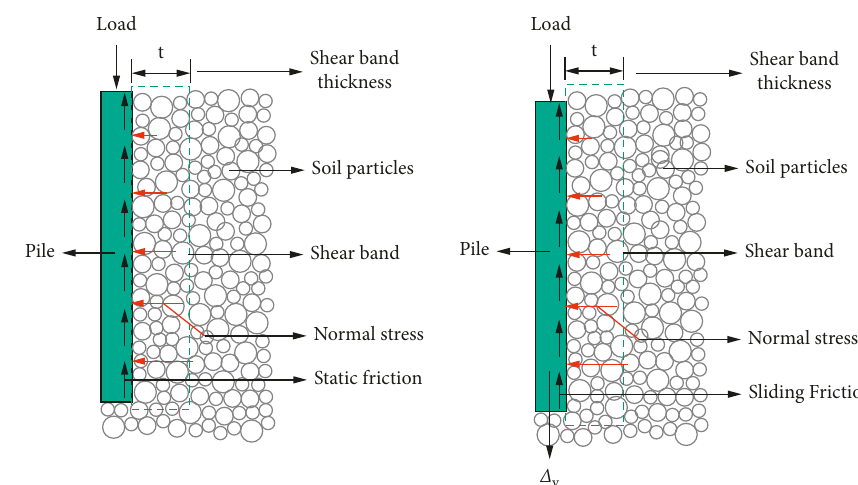
Figure 1: Schematic diagram of contact surface shear band.